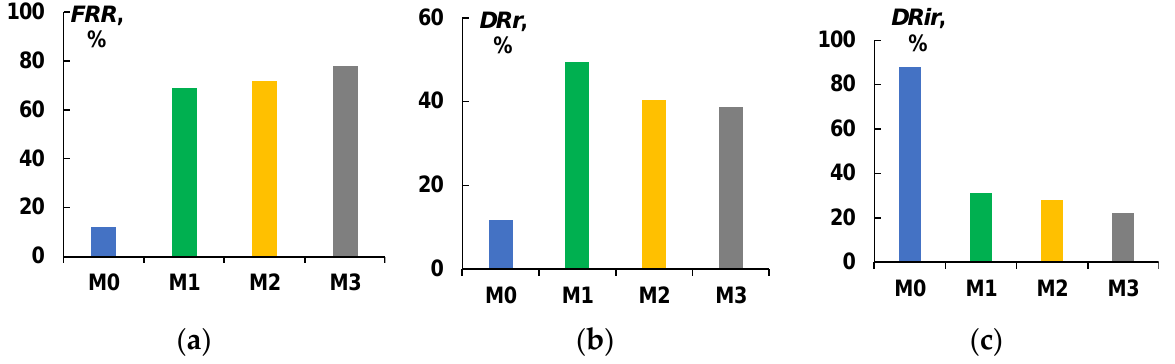
Figure 9. Fouling parameters of PSf-membranes: ( a ) flux recovery ratio ( FRR ); ( b ) reversible flux decline ratio ( DR r ), and ( c ) irreversible flux decline ratio ( DR ir )